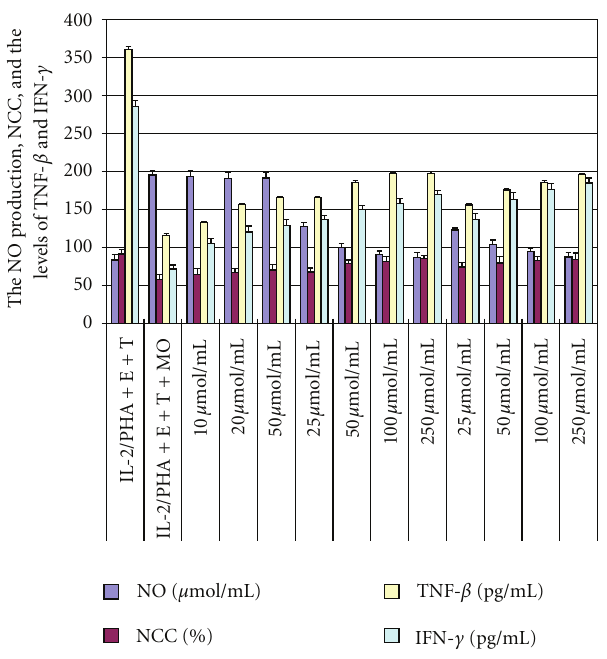
Figure 1: The e ff ect of di ff erent dosages of RNM scavengers on the activity of NK cells. With an increase of the dosage, the groups treated with TIP and GSH decreased the production of RNM and increased the levels of TNF- γ , IFN- β and NCC significantly ( P < 0 . 05). However, each group of DHT could not eliminate RNM ( P > 0 . 05).